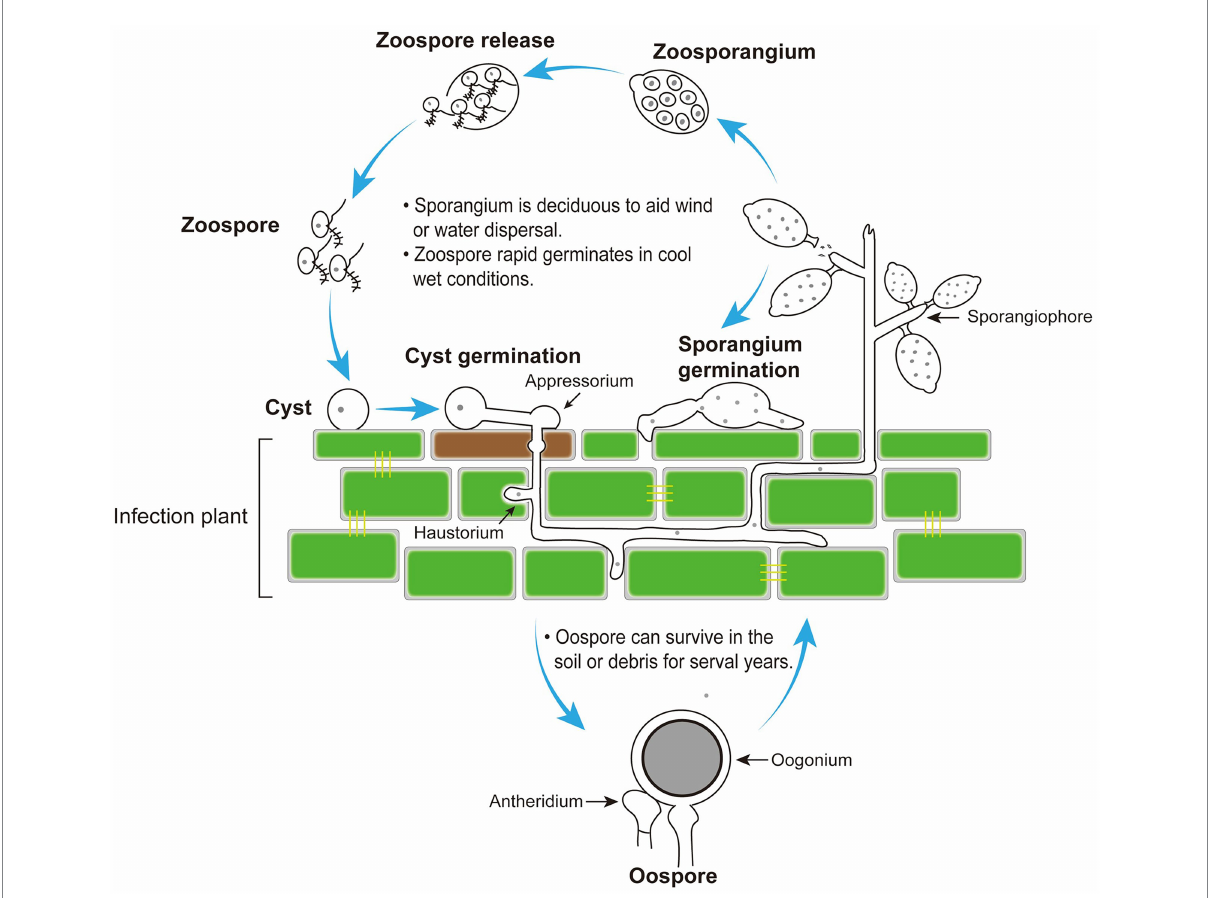
FIGURE 2 Disease cycle of Peronophythora litchii on host plant. The cycle can occur on leaves and fruit in the stage of litchi growth and fruit